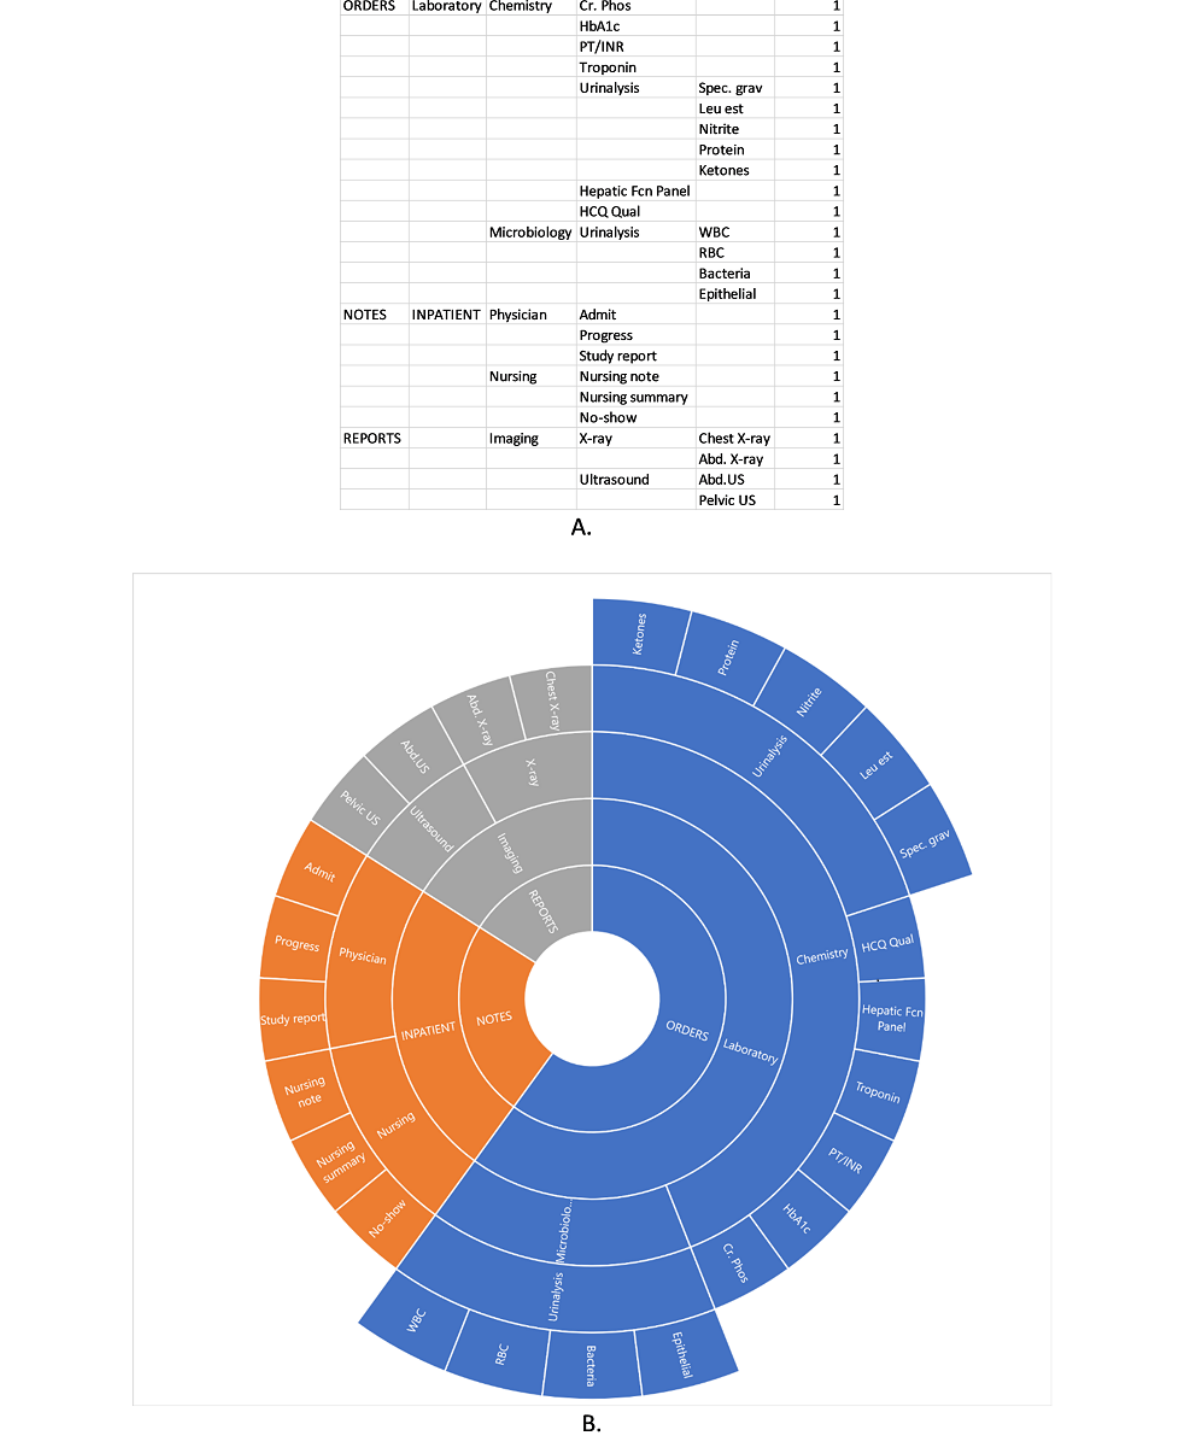
Figure 1. An example of sunburst chart data in Excel describing the system architecture (A) and the resulting sunburst diagram